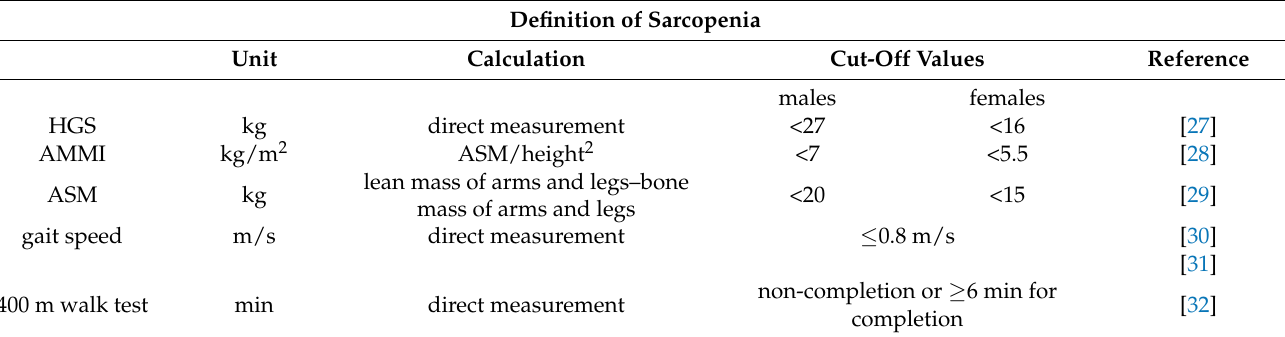
Table 1. Reference values for decreased muscle mass or